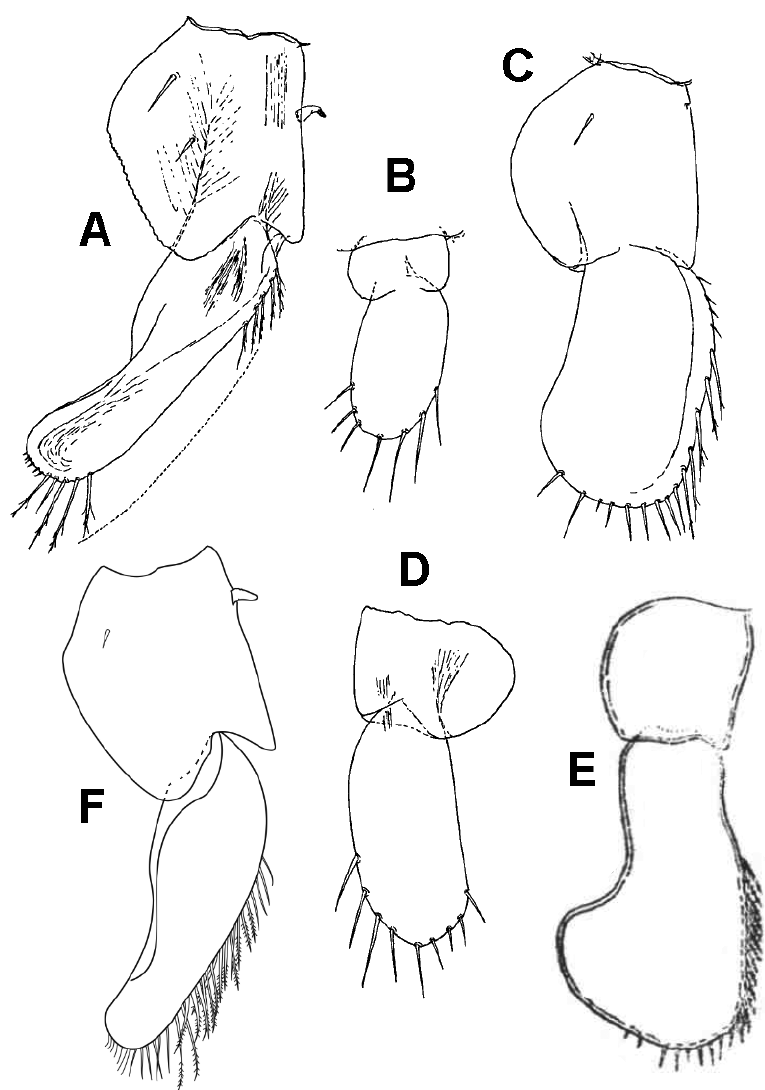
Figure 5. Male pleopod I of Stenasellus vermeuleni ( A ) S . grafi ( B ) S . messanai ( C ) S . henryi ( D ) S . asi- aticus ( E ) and S . tashanensis sp. n. ( F ). (Figures A–D from Magniez and Stock 2000; Figure E from Birstein and Starostin